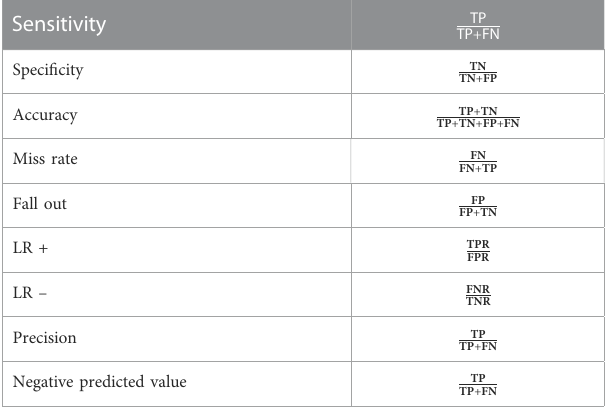
TABLE 1 Mathematical equations of confusion